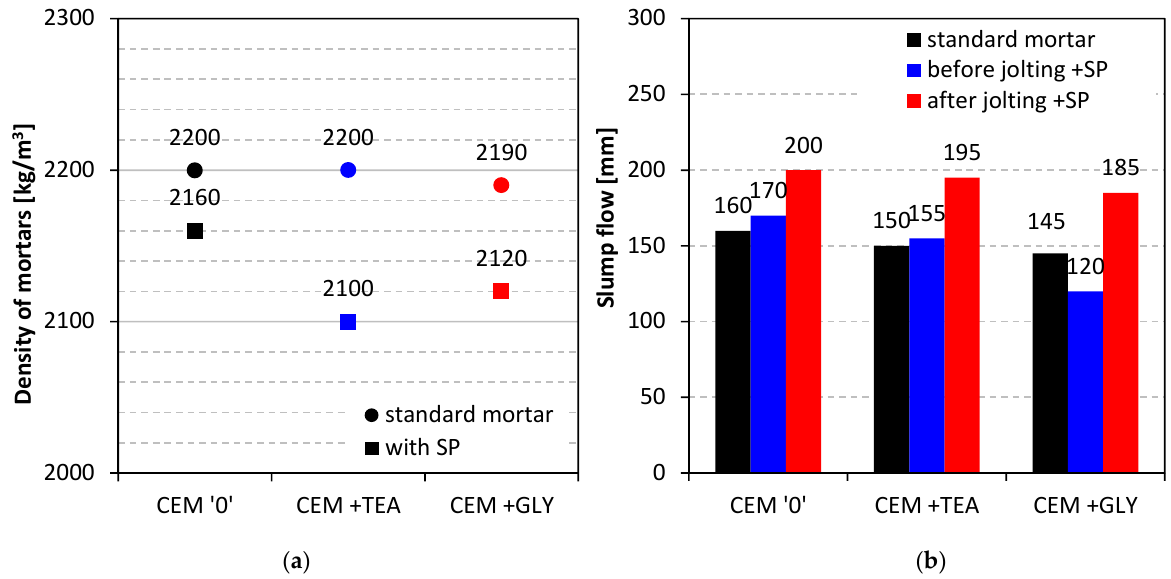
Figure 5. ( a ) Density and ( b ) slump flow of mortars with and without superplasticizer. The mortar prepared with the reference cement was characterized by a lower com- pressive strength after 1 day of hydration, compared with the mortars containing cements ground with surfactants (Figure 6). The results evened out after longer curing periods. After 7 days of hydration, the strength was similar in all series, whereas after 28 days, it was 11% and 5% lower for CEM + TEA and CEM + GLY mortars, respectively, compared to the reference sample. The influence of ethylene glycol and triethanolamine on the mechanical performance of mortars correlates well with the already published data [7].